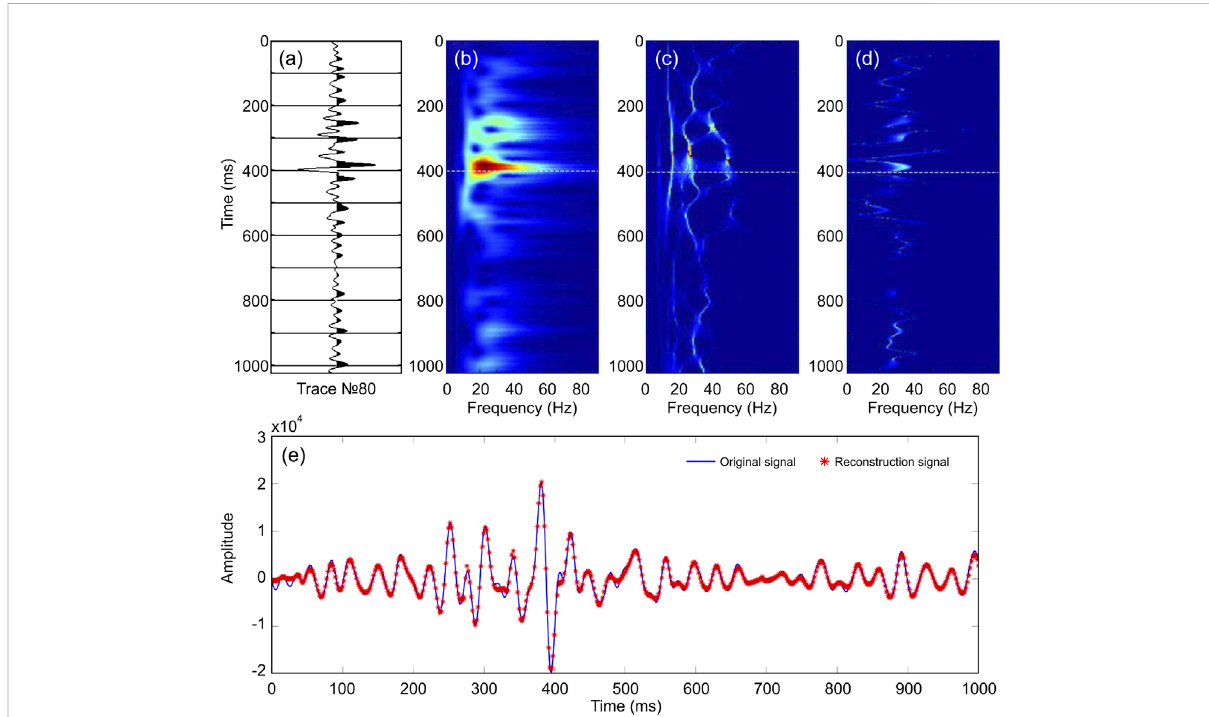
FIGURE 7 Comparison of single-channel seismic data. (A) Single-channel seismic data for trace No. 80; (B) time – frequency spectra of synthetic seismic traceusingthecontinuouswavelettransform(CWT); (C) time – frequencyspectraofsyntheticseismictraceusingtheCWT-basedsynchrosqueezing transform (SST); (D) time – frequency spectra of synthetic seismic trace using the improved SST; (E) Comparison between the original seismic signal and reconstructed seismic signal by the improved SST. The blue solid line represents the original signal s(t); the red asterisk represents the reconstruction signal [these are all plotted with MATLAB; (B – D) are displayed with the ‘ jet ’ colormap; red indicates higher amplitude].